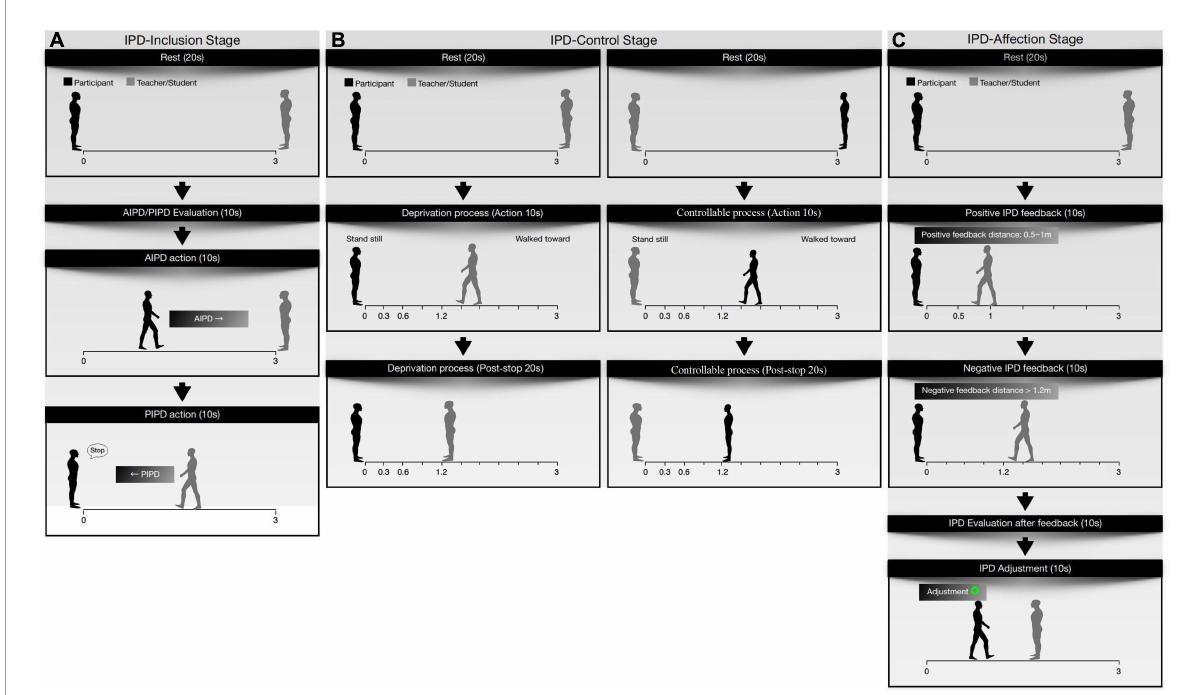
FIGURE3 Scenes of core experimental procedures. (A) Active interpersonal distance (AIPD) processes and passive interpersonal distance (PIPD) processes in experiment 1. (B) Before and after social IPD (1.2 m) procedure in experiment 2 in both deprivation and control processes. (C) Positive IPD feedback and negative IPD feedback from the partner and the IPD action (after feedback) of the participant in experiment 3.